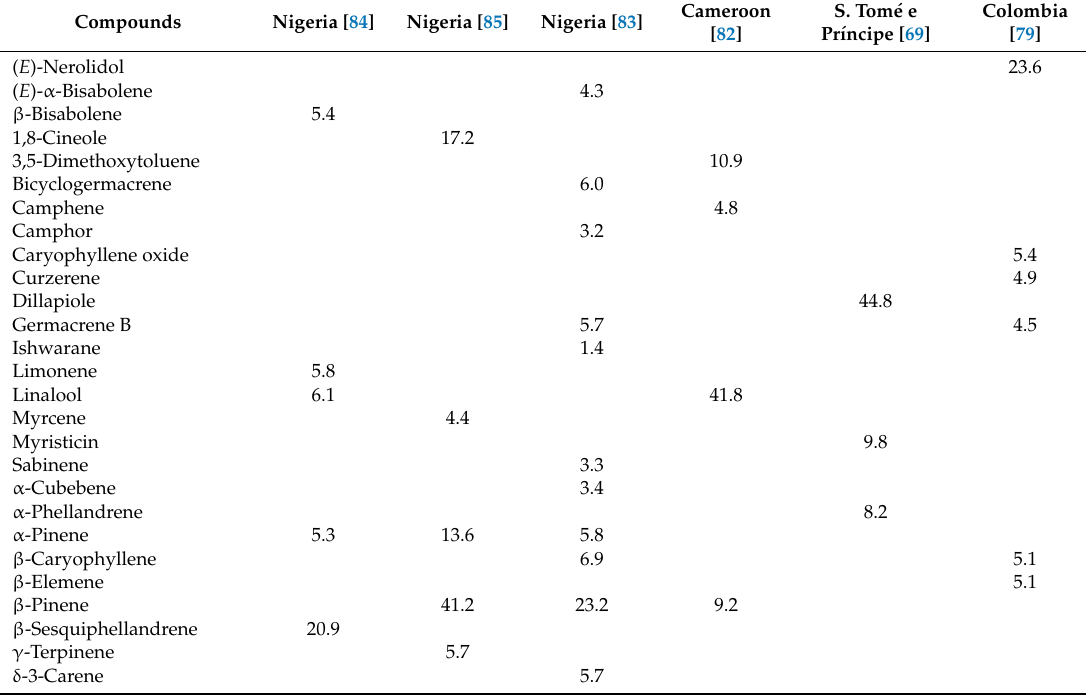
Table 19. Chemical compositions (%) of Piper guineense Schumach. & Thonn. fruit essential oils. Compounds Nigeria [84] Nigeria [85] Nigeria